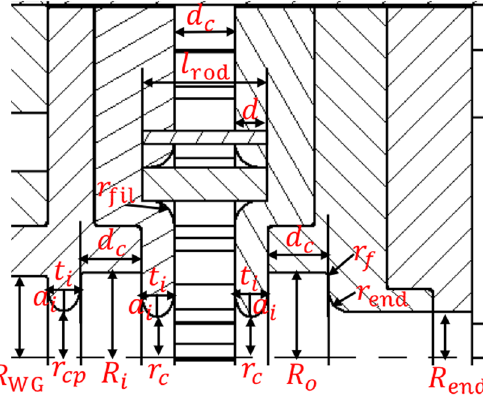
FIG. 7. Parameters specifying the HPBG structure.